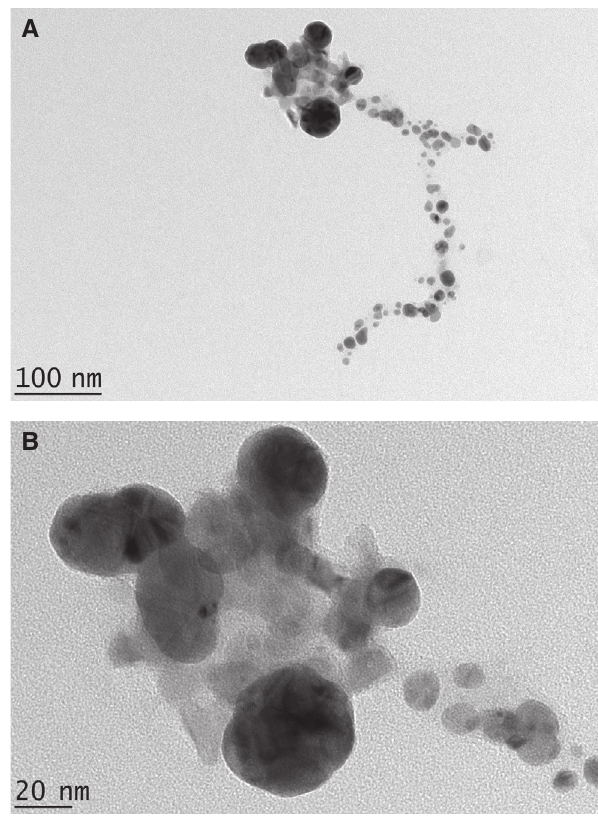
Figure 6: TEM images of AgNPs using M. charantia fruit extract at different